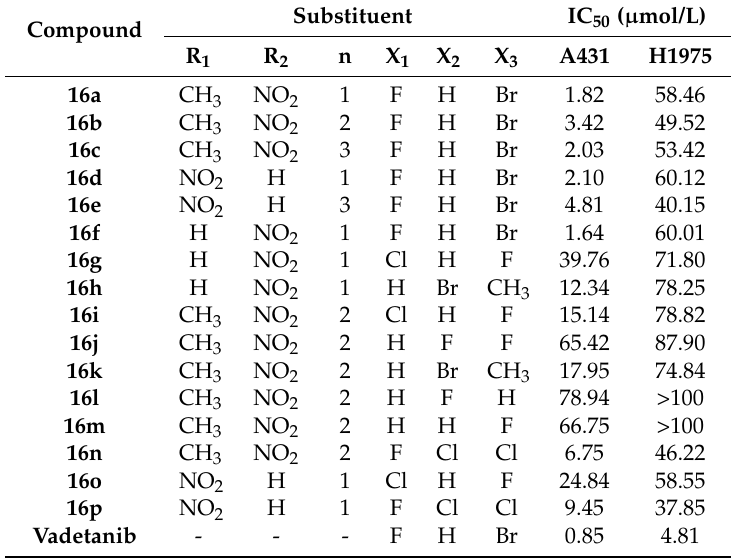
Table 1. In vitro EGFR inhibitory activity assay results of target compounds 16a – p .